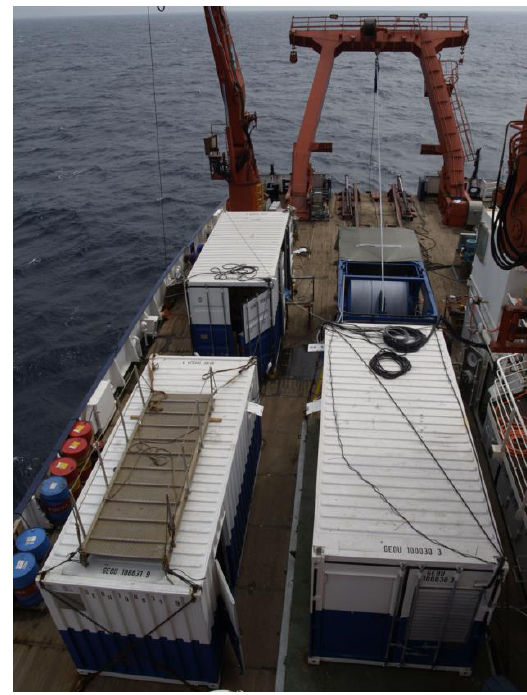
Fig. 3. View toward the stern on the working deck of the research vessel Meteor during deployment of the MeBo. At the front of the picture are the workshop and control containers, behind them the drill-pipe storage and winch, and behind those the launch and re- covery system for the MeBo (photo: V. Diekamp, Marum).